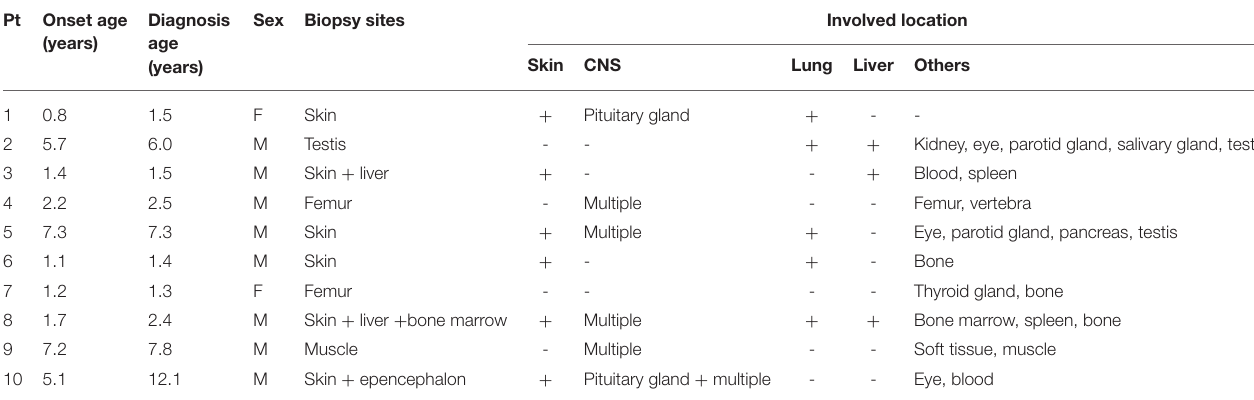
TABLE 1 | General information.